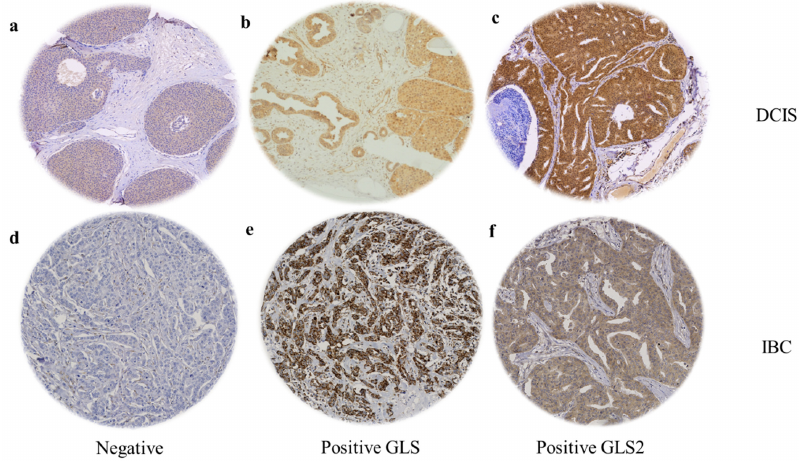
Figure 1. GLS and GLS2 protein expression in ER +/HER2- DCIS and invasive breast cancer. Representative TMA images (×20 magnification) depicting ( a ) negative immunostaining, positive GLS ( b ) and GLS2 ( c ) immunostaining in DCIS cases. ( d ) Negative immunostaining, positive GLS ( e ) and GLS2 ( f ) expression in invasive breast tumours.